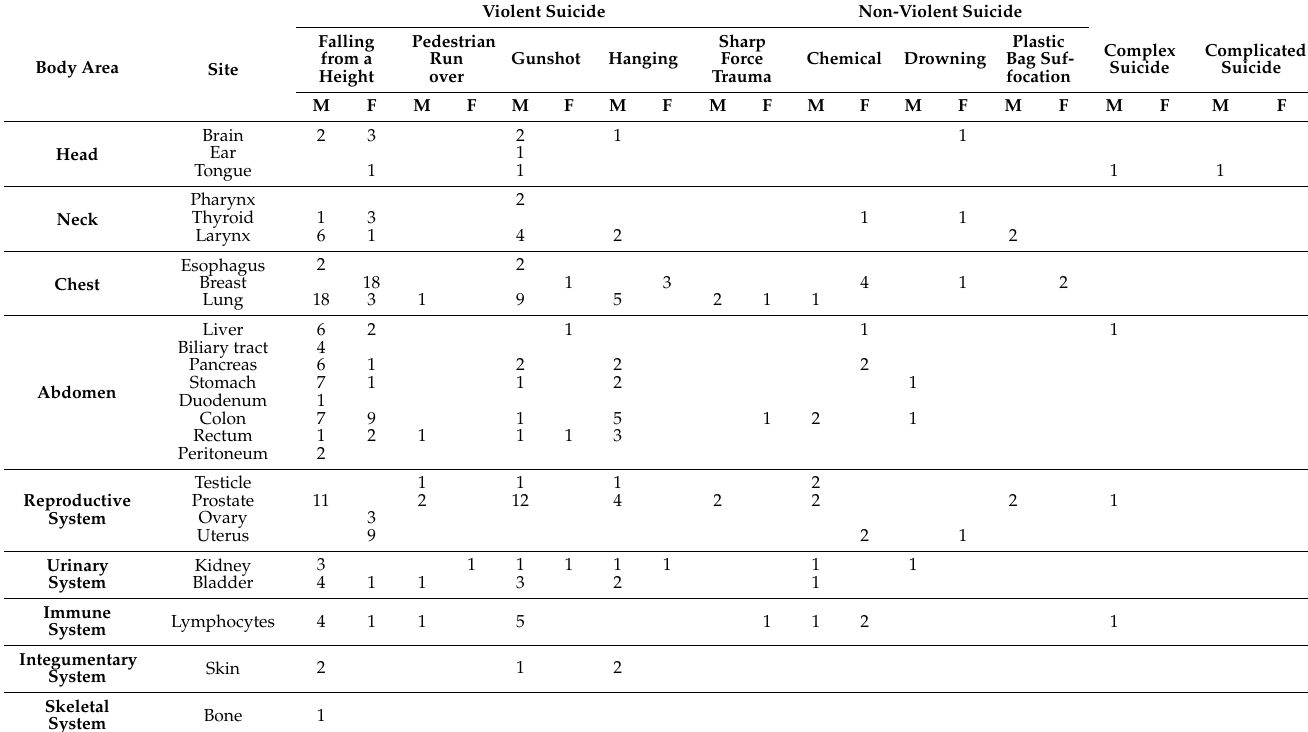
Table 5. Breakdown of victims based on sex, tumor site and applied detrimental suicide modality. Violent